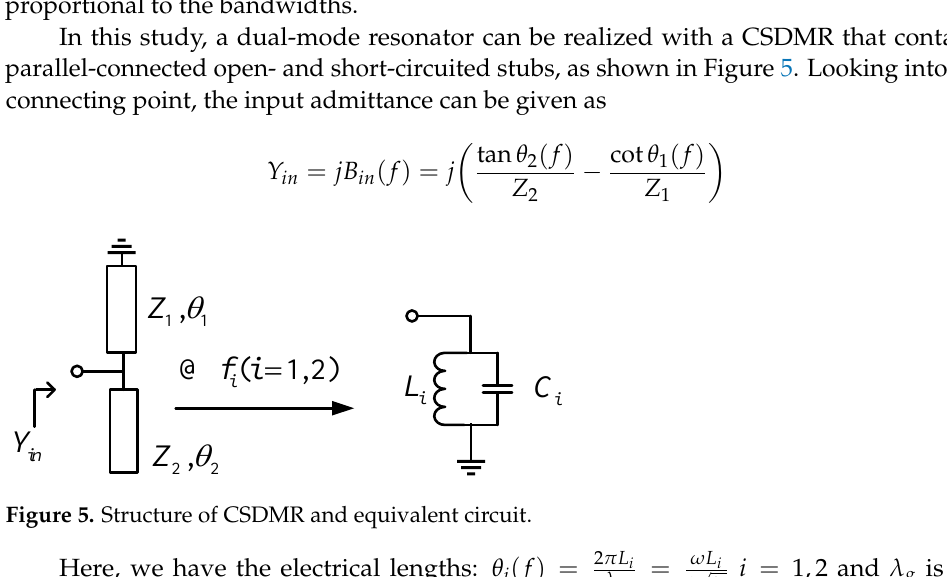
Figure 4. Topology structure of the passband filter.